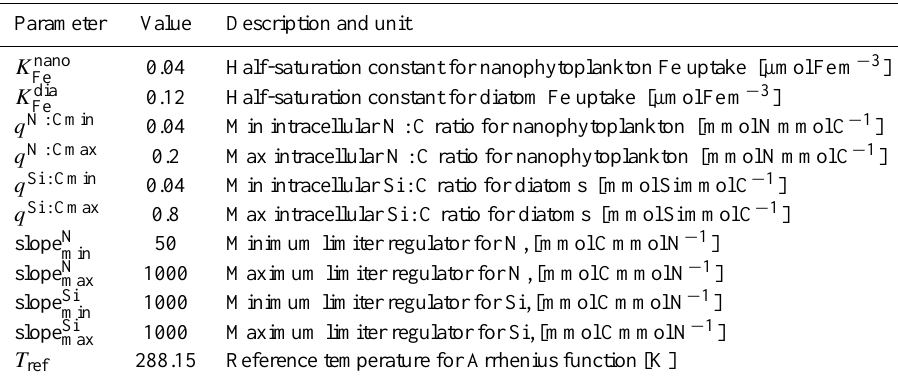
Table A10. Parameters for limitation functions.